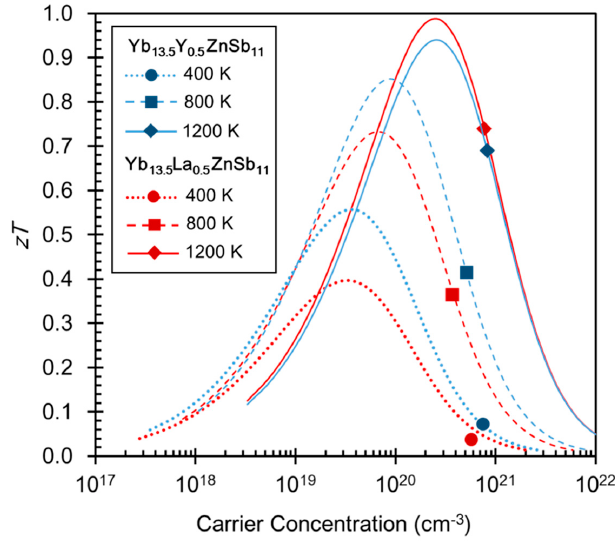
Figure 7. Pisarenko plots for the Yb 13.5 RE 0.5 ZnSb 11 (RE = Y, La) compounds calculated at 400, 800, and 1200 K.